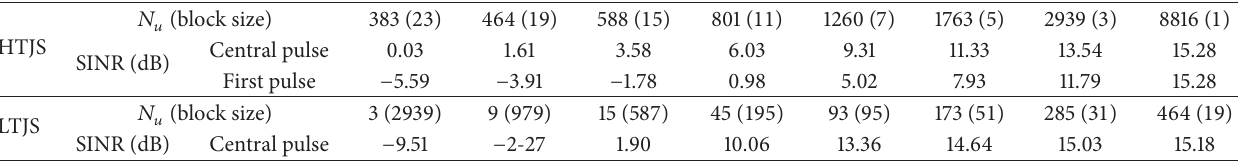
Table 5: Suboptimal WB approach in the azimuth dimension: SINR versus 𝑁 𝑢 and the block size.